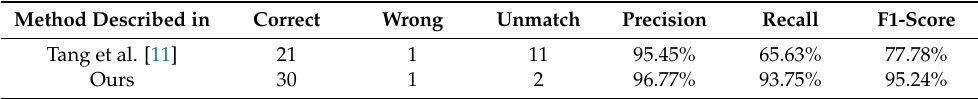
Table 3. Matching result for the methods.